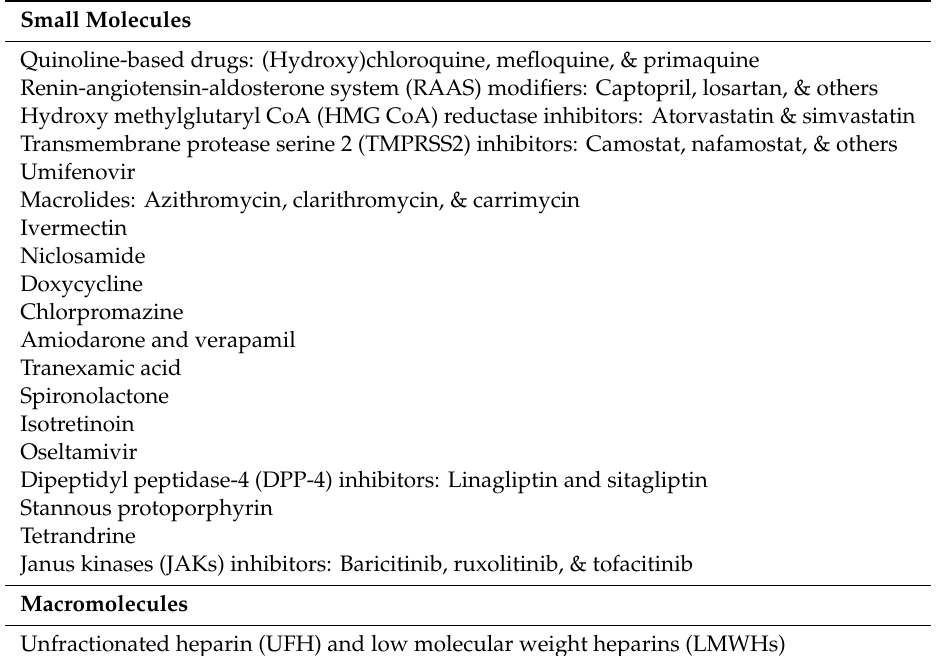
Table 1. The potential anti-COVID-19 therapeutics that are being tested in clinical trials based on targeting the early events of the life cycle of SARS-CoV-2 (a)